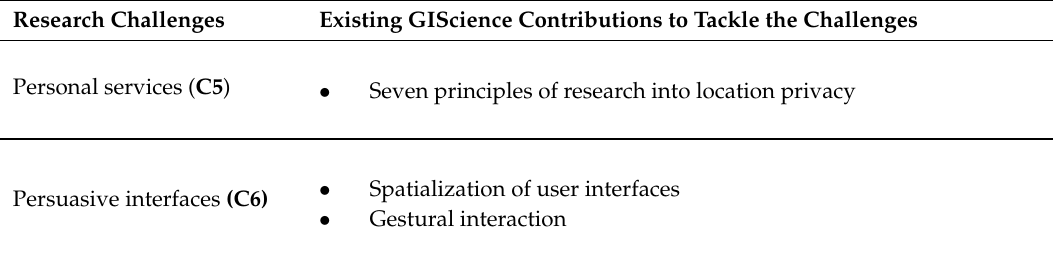
spatialization of user interface can guide research into personal services and persuasive